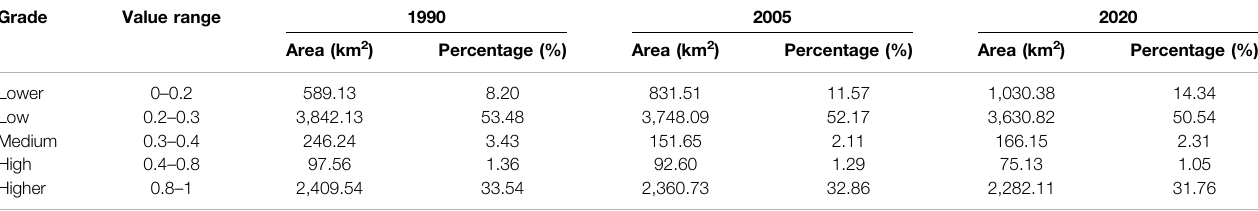
TABLE 7 | Area and percentage of habitat quality for each grade.